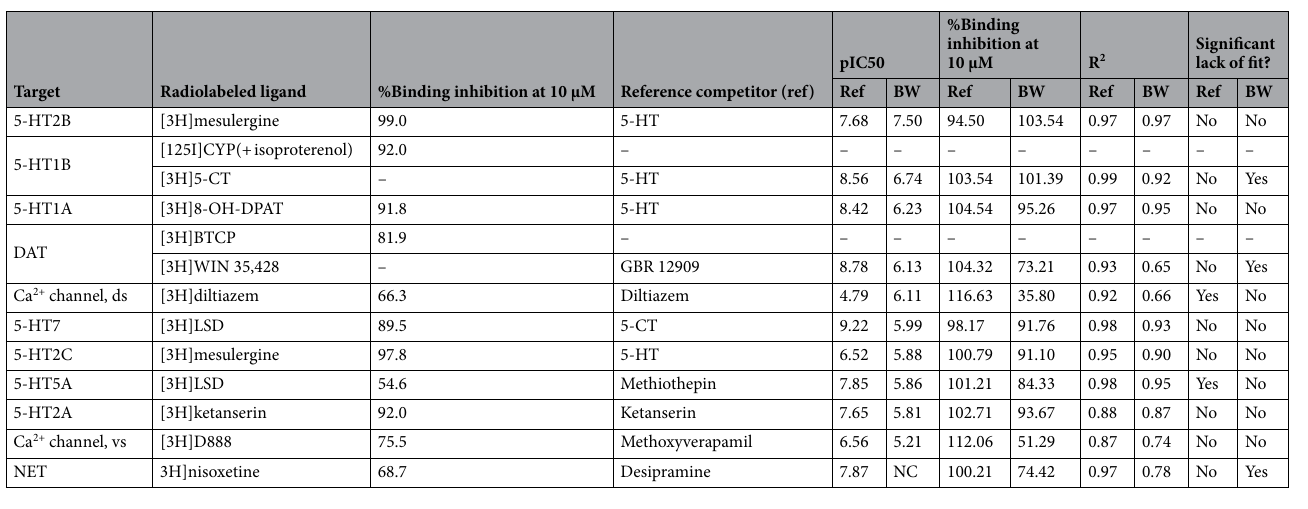
Table 1. Pharmacological characterization of BW. Results of binding studies on the 11 most potent targets of BW. BW is a full and fairly selective agonist on 5-HT 2B